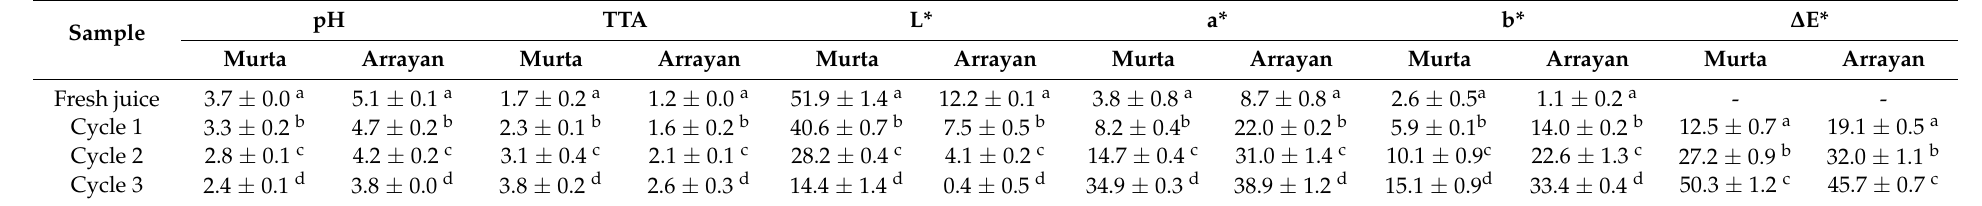
Table 1. Physicochemical characteristics of the